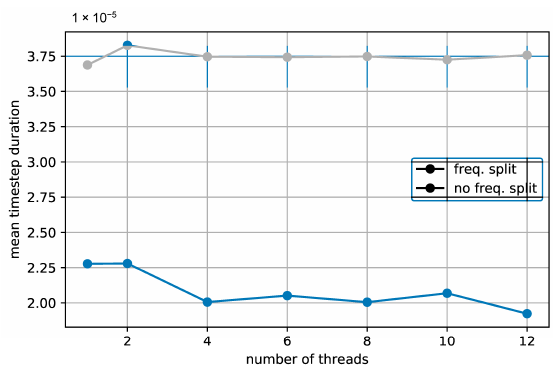
Figure 17. Parallelization results for single phase